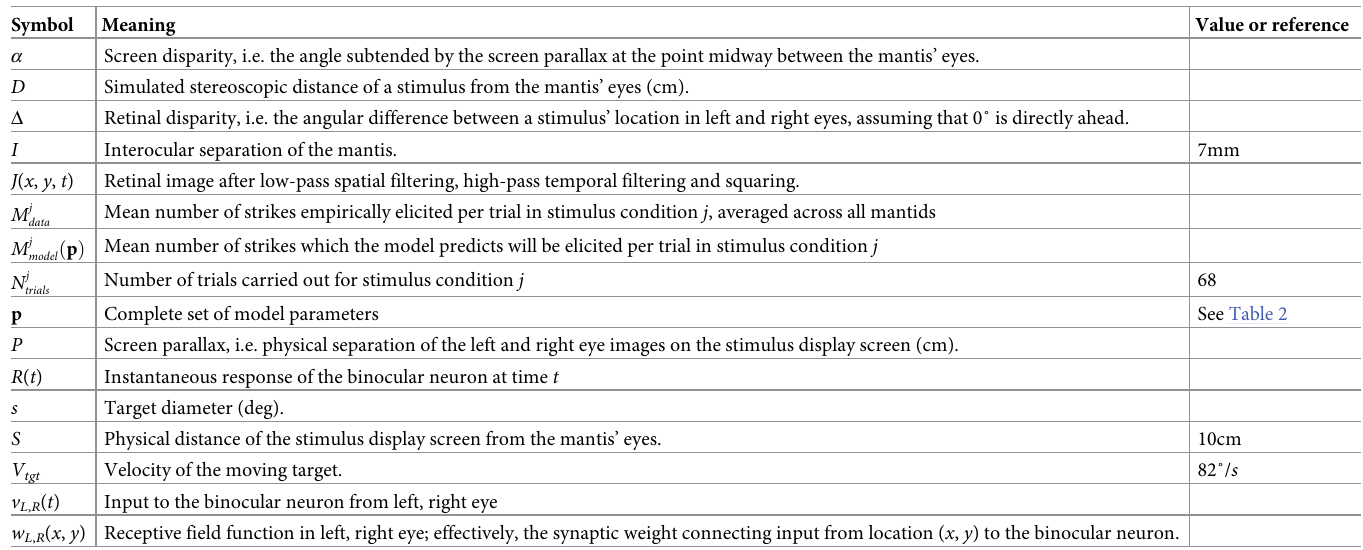
Table 1. Symbols used in the paper. Symbols used for model parameters are given separately in Table 2, along with fitted values. Symbol Meaning Value or reference α Screen disparity, i.e. the angle subtended by the screen parallax at the point midway between the mantis’ eyes. D Simulated stereoscopic distance of a stimulus from the mantis’ eyes (cm). Δ Retinal disparity, i.e. the angular difference between a stimulus’ location in left and right eyes, assuming that 0˚ is directly ahead. I Interocular separation of the